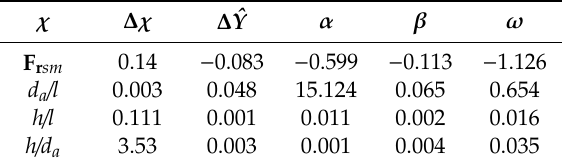
Table 3. Results of sensitivity analysis with 10% reduction in ∆ χ .